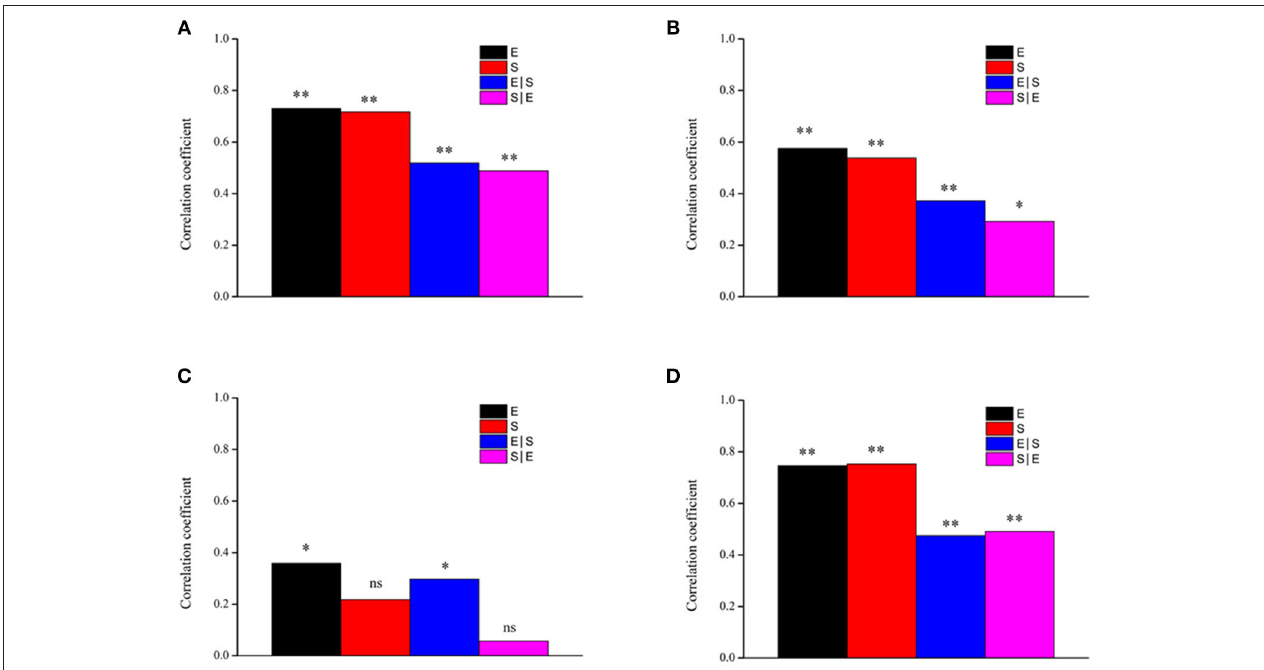
FIGURE 8 | Mantel and partial Mantel tests for the correlation between bacterial community dissimilarity and environmental and spatial factors using Pearson’s coefficient. * P < 0.05, ** P < 0.01. (A) All; (B) Generalists; (C) Specialists; (D) Other taxa. E environmental variables, S spatial variation, S|E pure spatial variation, E|S pure environmental variation, ns not